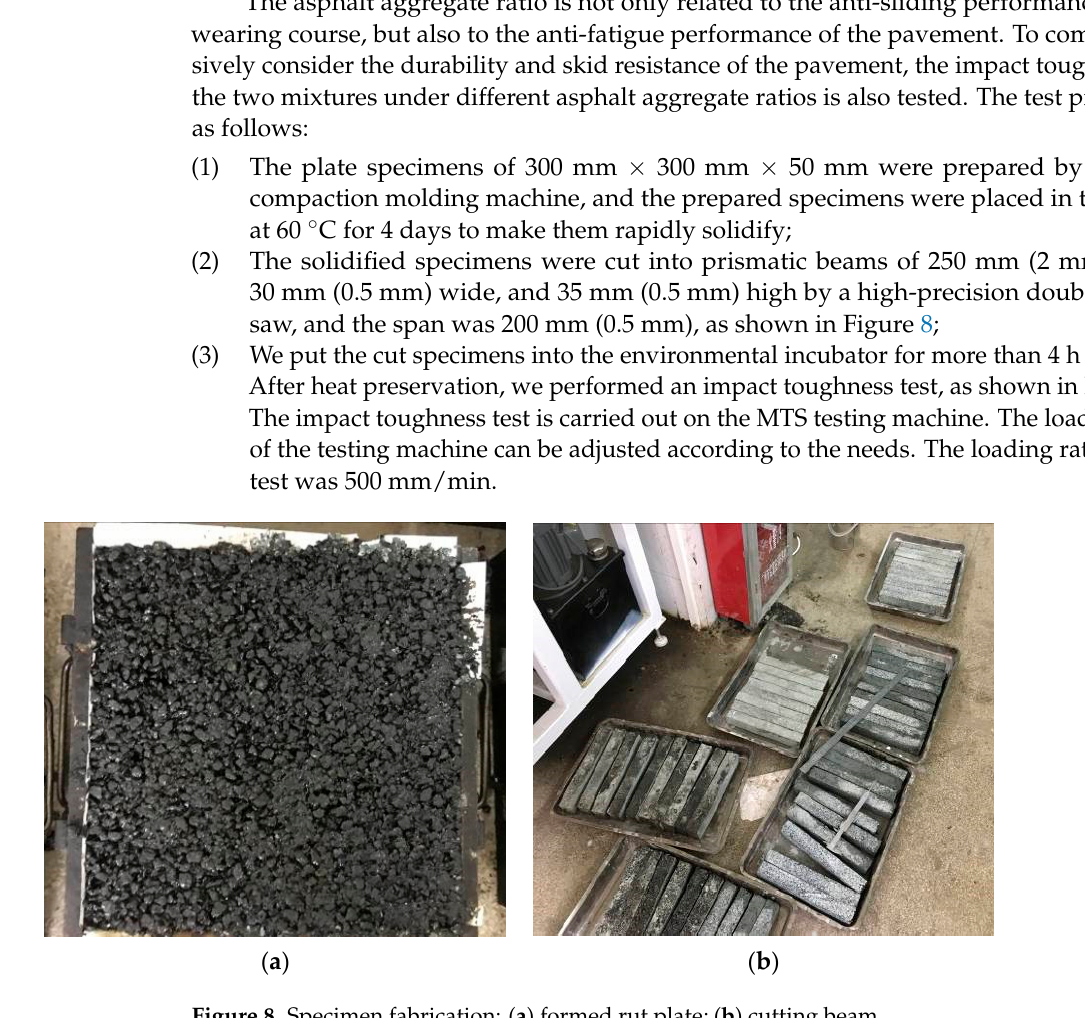
Figure 7. Testing equipment: ( a ) pendulum friction device; ( b ) avement structure depth tester.